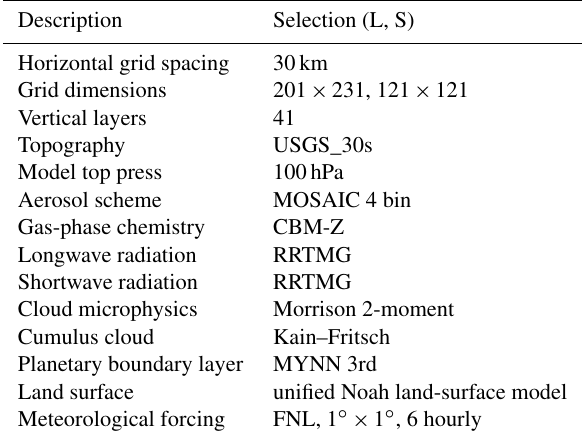
Table 2. Summary of model